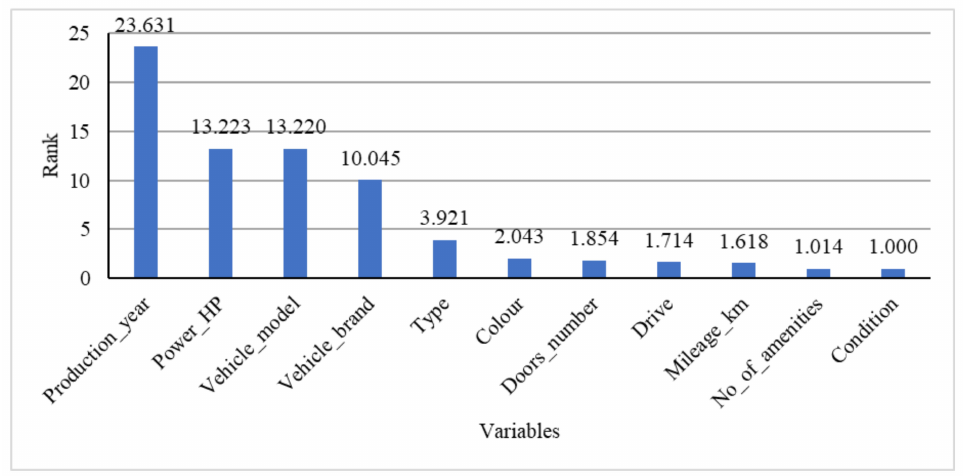
Figure 11. The results of the sensitivity analysis of the Id 88 network (MLP 140-3-1).